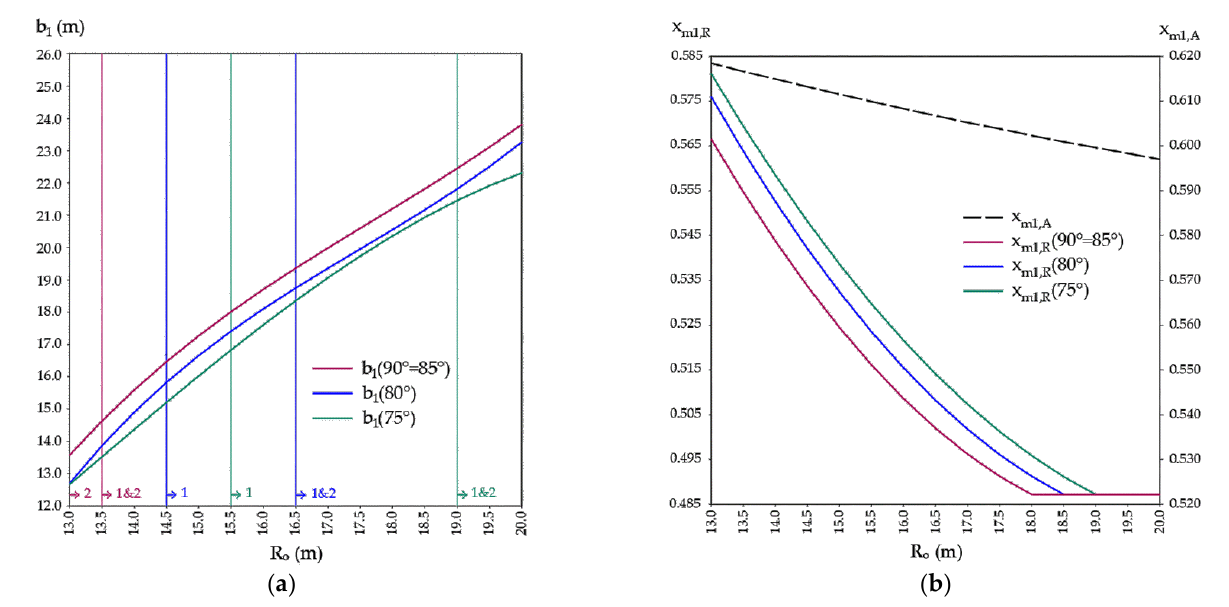
Figure 9. Investigated parameters at leg 1 as a function of R o for different δ, considering the appli- cation of design conditions 1 and 2: ( a ) geometric parameter b 1 ; ( b ) traffic parameter x m1 .